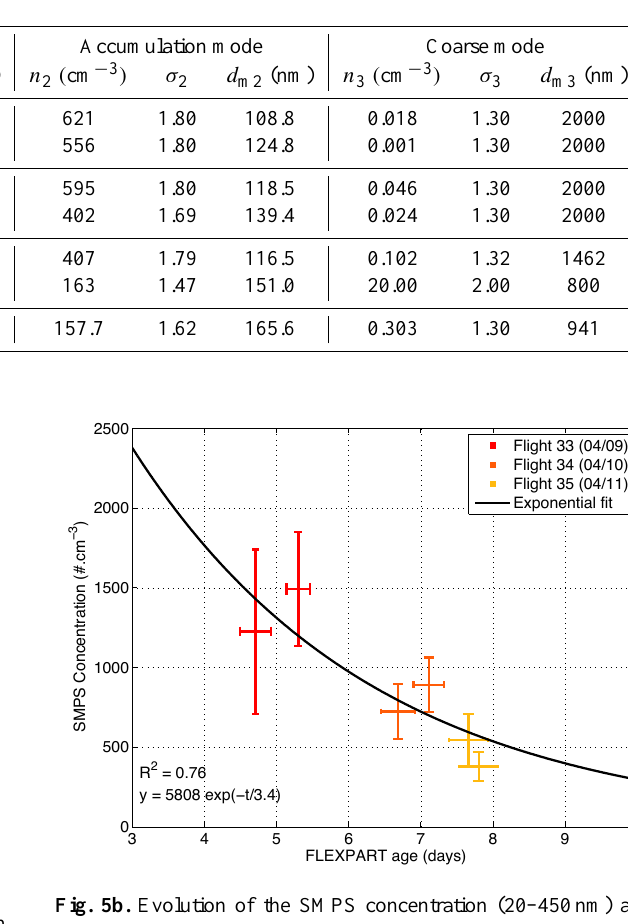
Table 2. Parameterisation of log-normally fitted size distributions for the anthropogenic plume. FLEXPART determined air mass ages are also indicated.